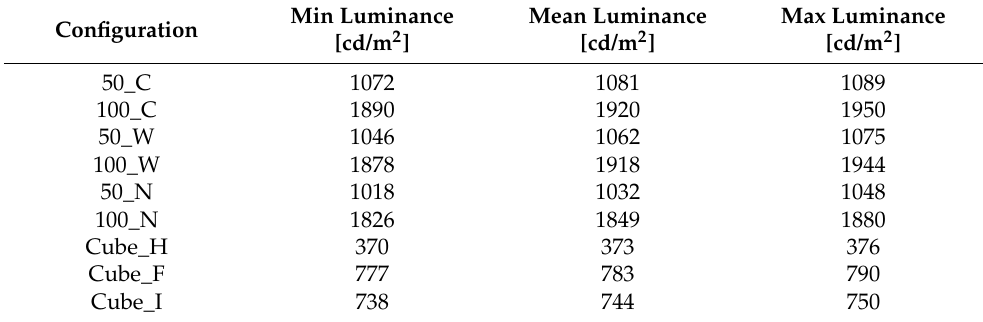
Table 2. Luminance values of the selected regions for the different configurations (3 × 3